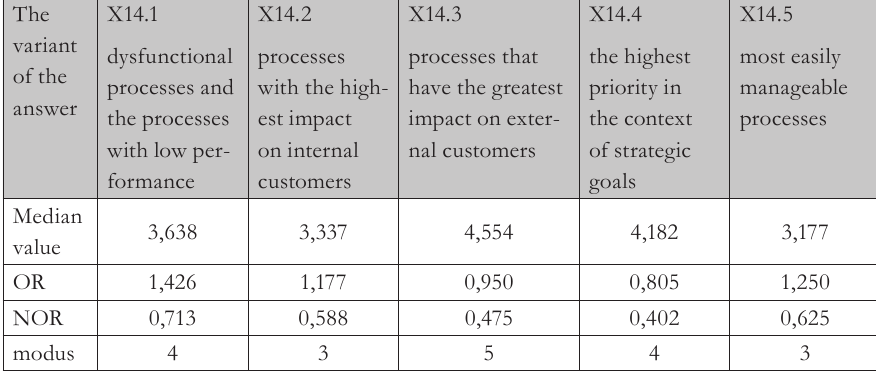
Tab. 3 – Criteria of the Process Selection for BPM activities (in 2013) – descriptive statistics and its graphical representation. Source: own